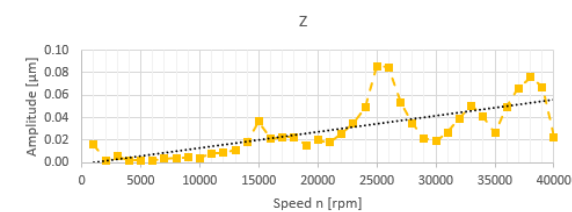
Fig. 5. Operational deflection shape: dominant vibrations in relation to speed of “Ultrasonic 20 linear”